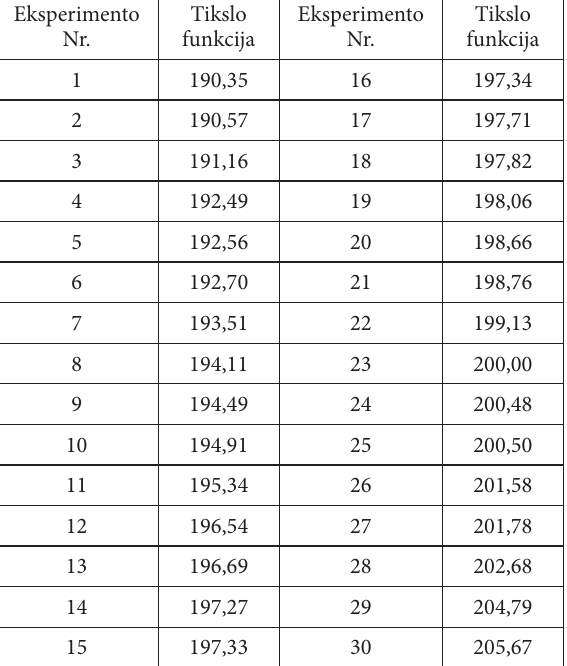
Table 1. Results for task of reactive forces minimization for 10 pole grillage Eksperimento Tikslo Eksperimento Nr. funkcija